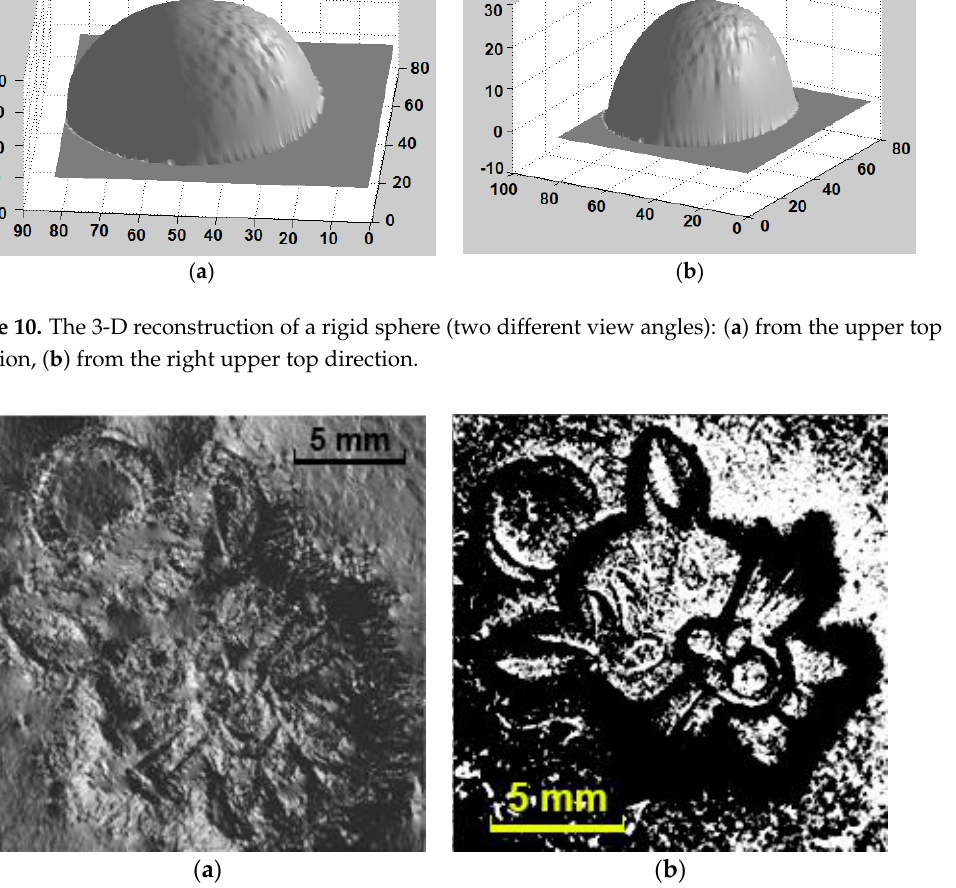
Figure 11. The 3-D reconstruction of a 2-cm mascot: ( a ) reconstructed image, ( b ) shadow detected using the proposed shadow detection method (the white areas/dots represent the shadow).